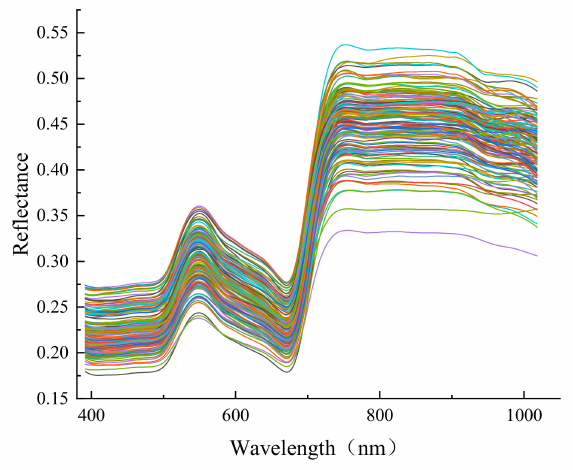
Figure 6. Savitzky-Golay convolutional smooth data.